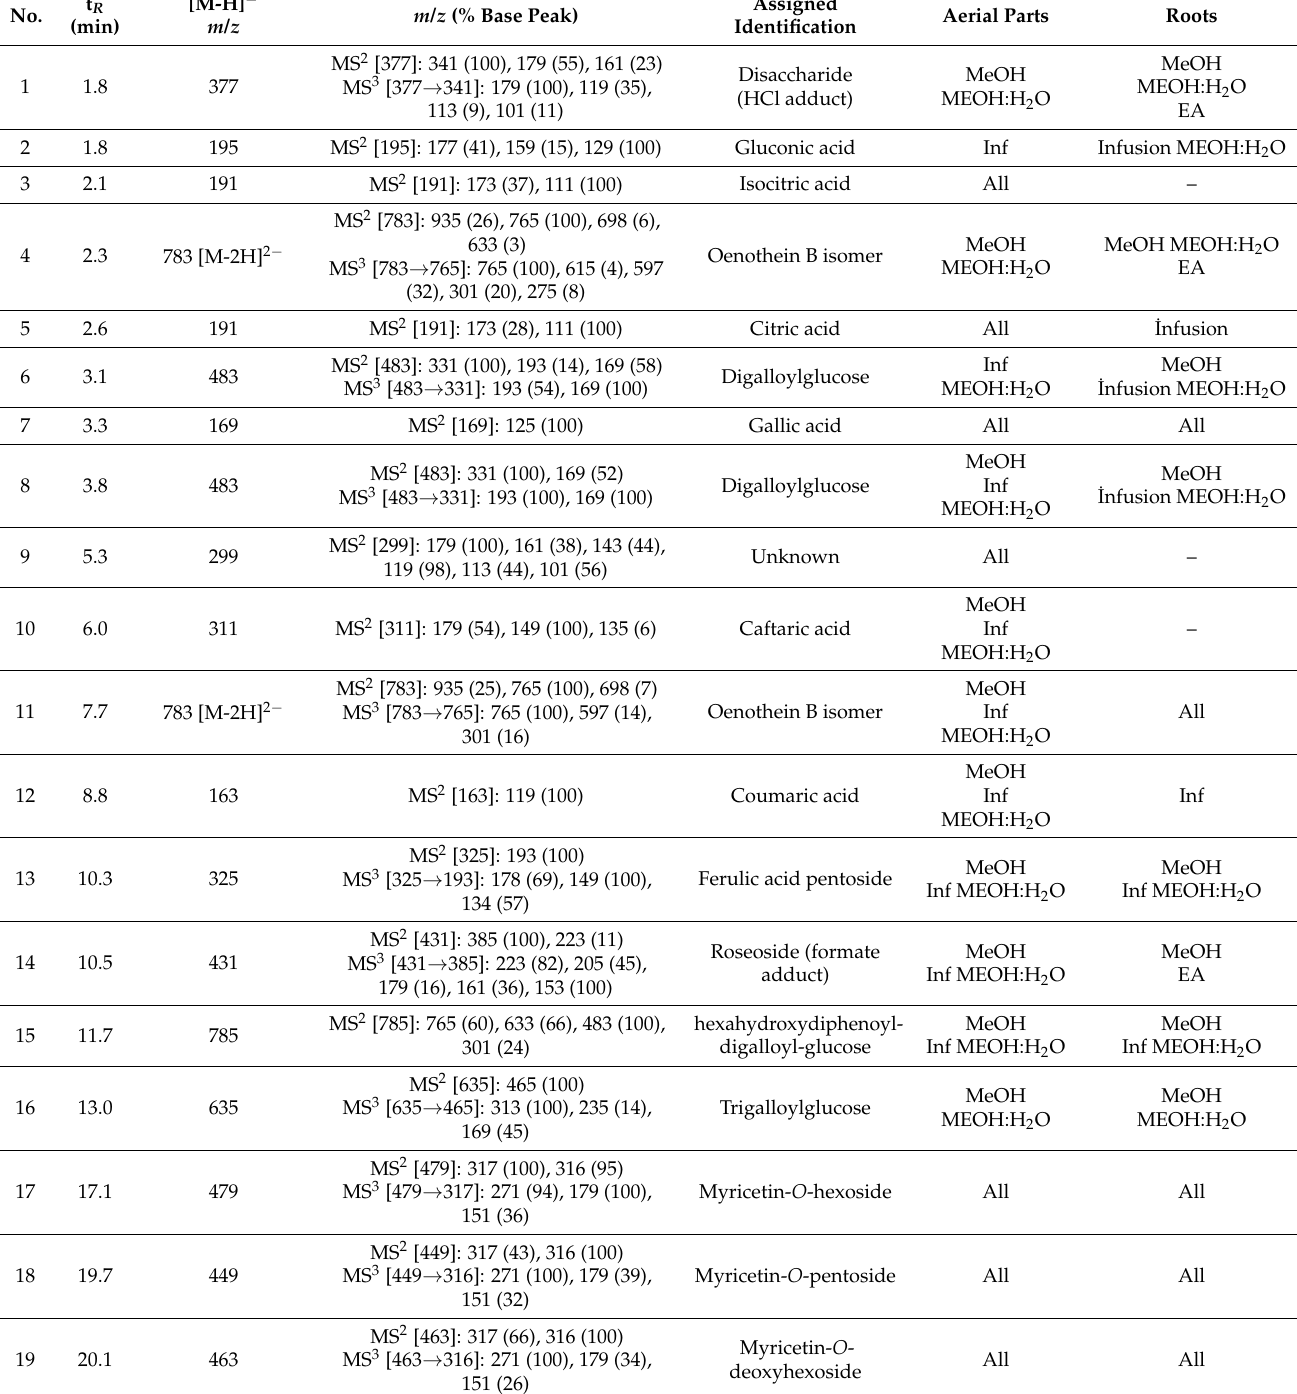
Table 2. Characterization of the compounds found in the analyzed extracts of Epilobium hirsutum